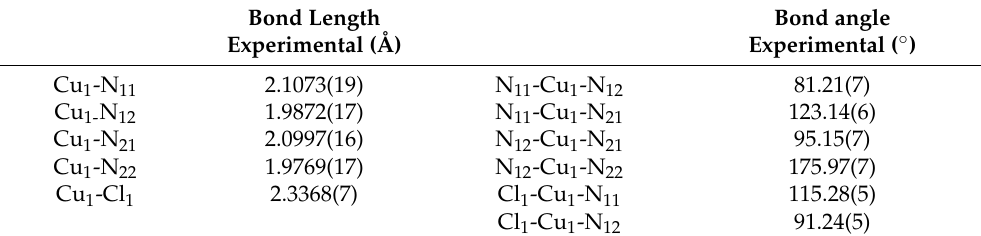
Table 2. Selected bond lengths and bond angles of [Cu(phen) 2 Cl].